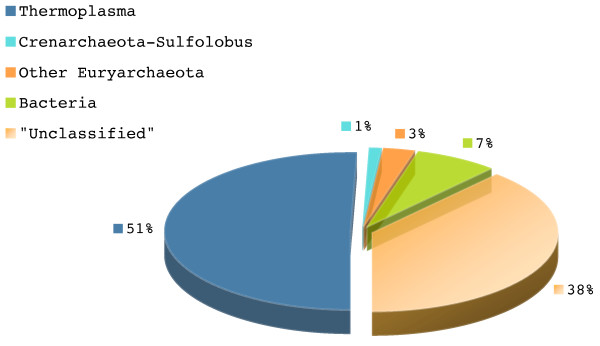
Distribution of taxonomic assignments for Thermoplasma acidophilum. Proportions of genomic fragments originating from the T. acidophilum genome that are misclassified into other taxonomic groups.